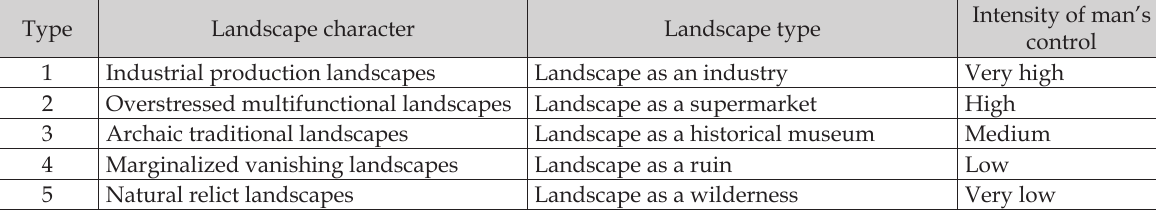
Table 4. Landscape types according to different intensities of man’s control (acc. to Vos, Meekes 1999).